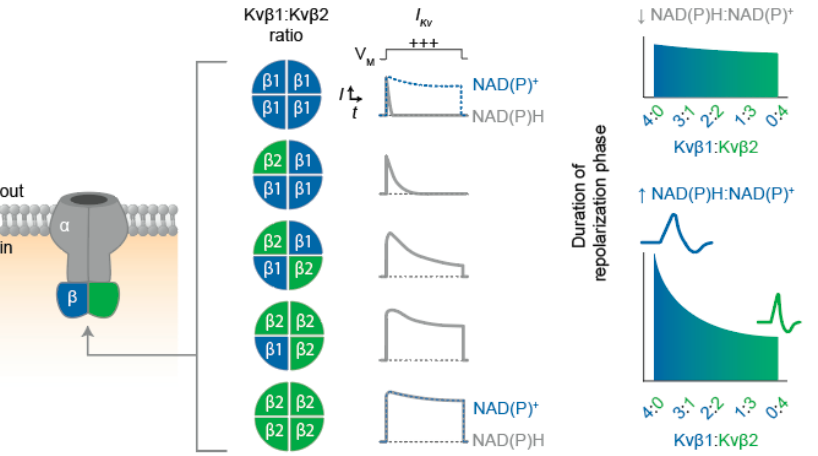
Figure 3. Proposed influence of the Kv β 1:Kv β 2 functional expression on I Kv inactivation and repolarization. Schematic illustration depicting Kv α 4 β 4 channel assembly ( left ) with possible combinations of Kv β proteins present in native heteromultimeric structures. ( Center ) Expected impact of Kv β stoichiometry on current inactivation rates is exemplified with theoretical trace recordings of depolarization (+++) ‐ evoked whole ‐ cell I Kv for cells expressing homogenous channel populations with the Kv β ratios as indicated. Differential effects of the bound cofactor for β 1 (4) and β 2 (4) configurations are shown in dashed blue traces. ( Right ) Predicted influence of differential Kv β stochiometries on action potential duration in the presence of low and high cytosolic NAD(P)H:NADP + ratios.